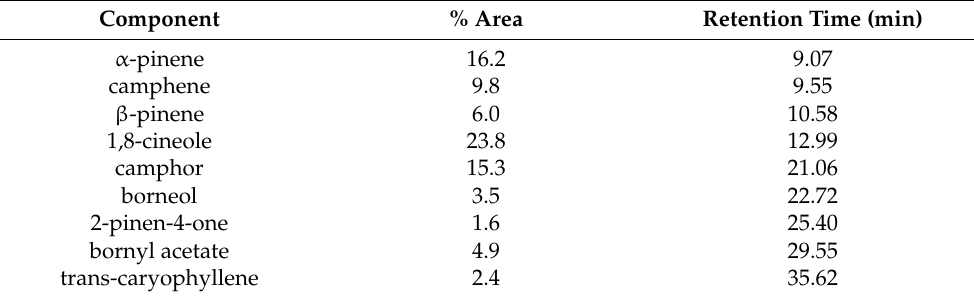
Table 1. Main components of REO analyzed by GC–MS.